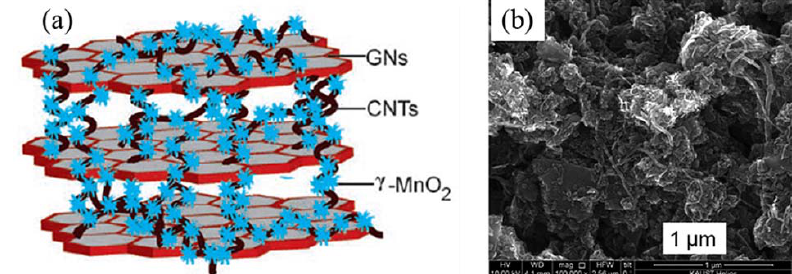
Figure 14. ( a ) Schematic diagram of the ternary graphene-( γ -MnO structure; ( b ) SEM image of the ternary graphene-( γ -MnO Adapted with permission from [39]. Copyright 2012 John Wiley and